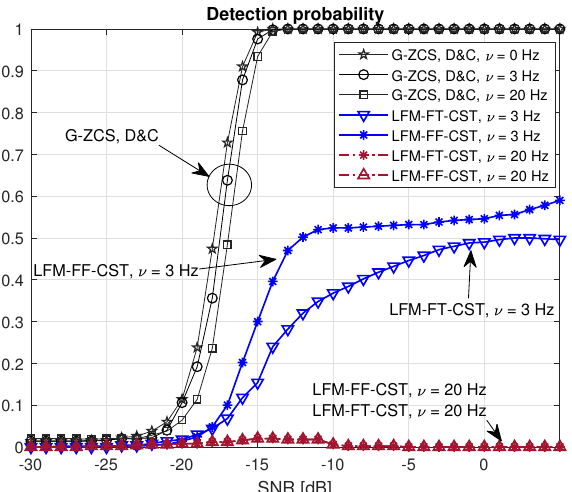
Figure 9. Detection probabilities of the proposed G-ZCS, D&C, and conventional CSTs (AWGN).